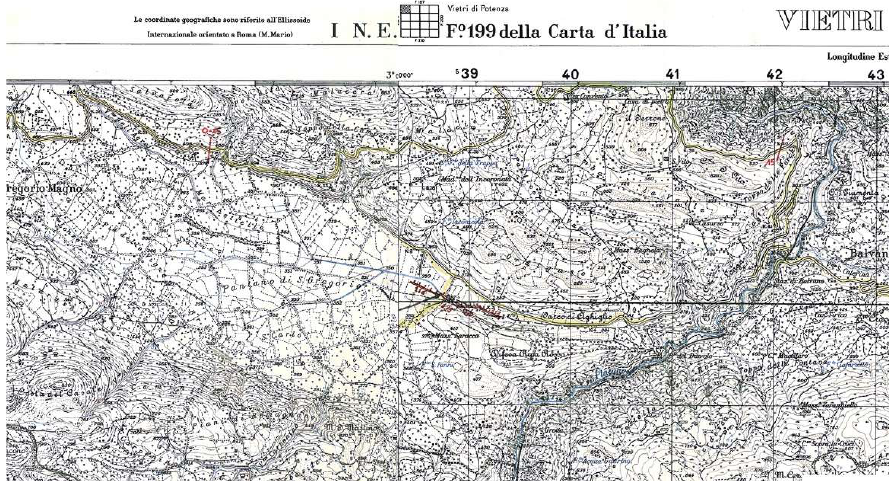
Figure 7. Detail of the original 1:25,000 scale topographical map with the most important geological effects surveyed by Italian geologists immediately after the earthquake of 23.11.1980 (fractures, landslides, faults by Carmignani et al, 1981 [11], see also Supplementary Materials S1); note the trace of the most relevant primary earthquake ruptures located at Pantano di San Gregorio (courtesy of Paolo Scandone,